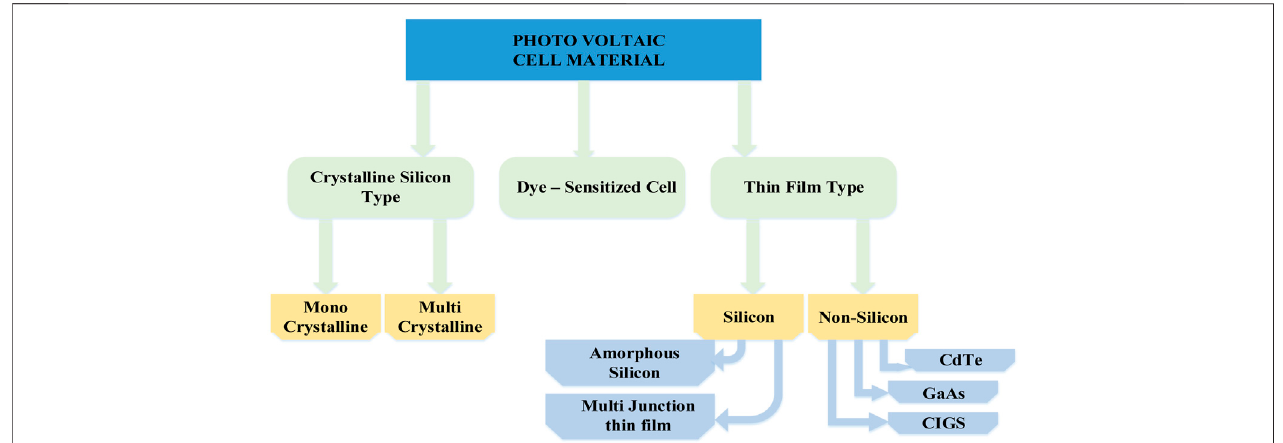
FIGURE 2 | Basic structure of photovoltaic